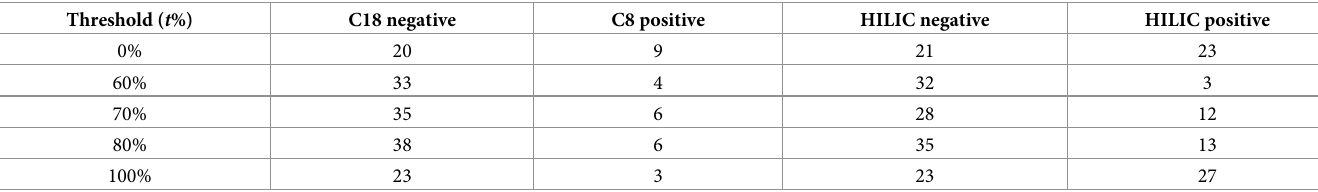
Table 2. Each cell in the table represents the number of selected metabolites under different modes of data collection and threshold. Threshold ( t %)